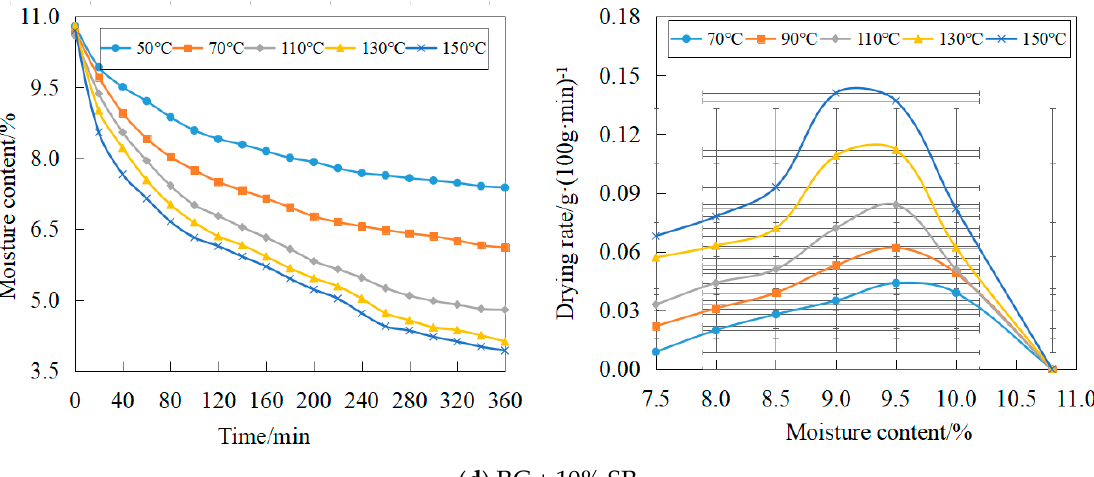
Figure 4. Coking coal drying curve and drying rate curve.